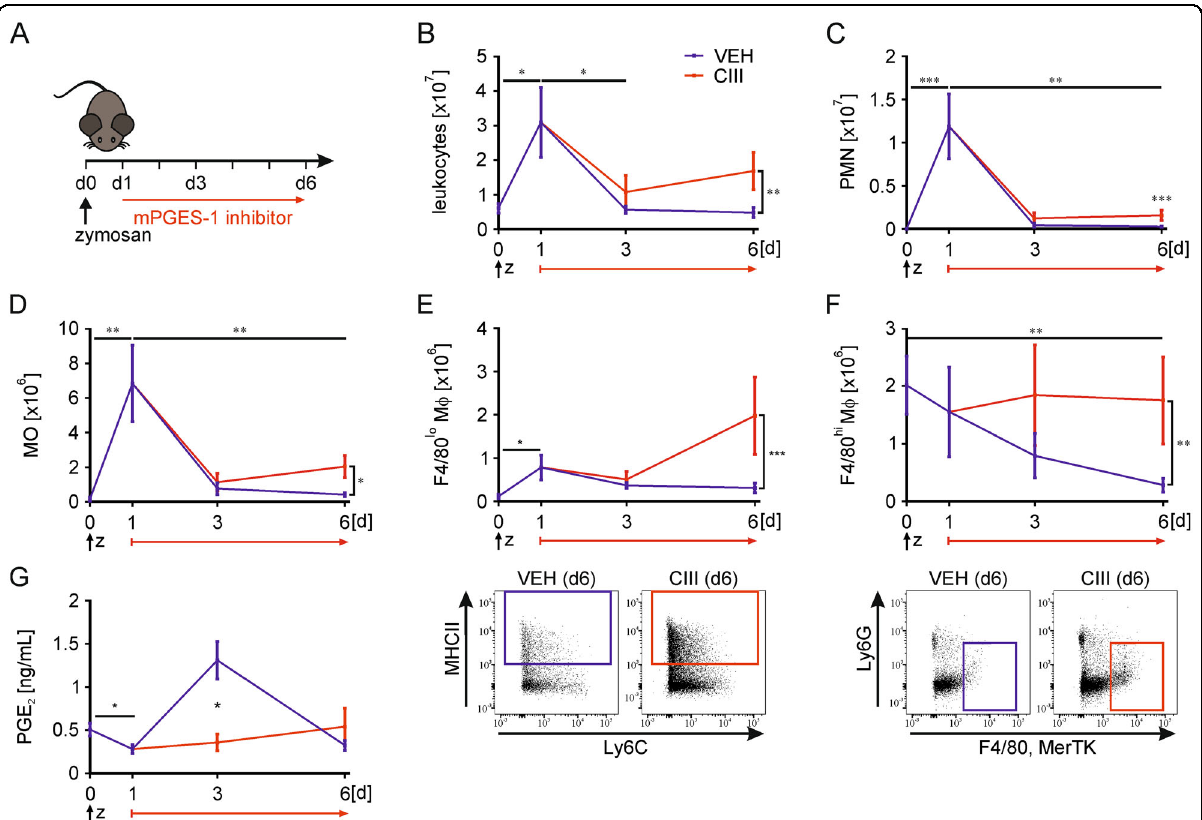
Fig. 1 Inhibition of mPGES-1 alters the cellular composition during resolution of zymosan-induced peritonitis. A Starting 24 h post i.p. zymosan (5 mg/kg) injection, mice received daily i.p. injections of the mPGES-1 inhibitor compound III (CIII) (25 mg/kg) or the appropriate vehicle control (VEH). B – F Cellular composition of the peritoneal lavages was analyzed by FACS. Numbers of viable ( B ) leukocytes (CD45 + ), ( C ) PMNs (CD11b + , Ly6G + ), ( D ) monocytes (MO; Ly6G lo , F4/80 lo , MerTK lo , MHCII – ), ( E ) F4/80 lo (Ly6G lo , F4/80 lo , MerTK lo ), and ( F ) F4/80 hi (Ly6G lo , F4/80 hi , MerTK hi ) macrophages (M ϕ ) in the peritoneum. Representative dot-blots of ( E , lower panel ) F4/80 lo M ϕ and ( F , lower panel ) F4/80 hi M ϕ at day 6. G PGE 2 concentrations in the peritoneal lavages were determined by LC/MS/MS. Data are represented as means ± SEM ( n ≥ 6 per group). For statistical analysis within each treatment, one-way ANOVA with Holm – Sidak posthoc test was used for parametric data, otherwise, Kruskal – Wallis test was used. Analysis between the treatments for parametric data was done via two-way ANOVA with Holm – Sidak posthoc test, non-parametric data were log- transformed (* p < 0.05, ** p < 0.01, *** p <